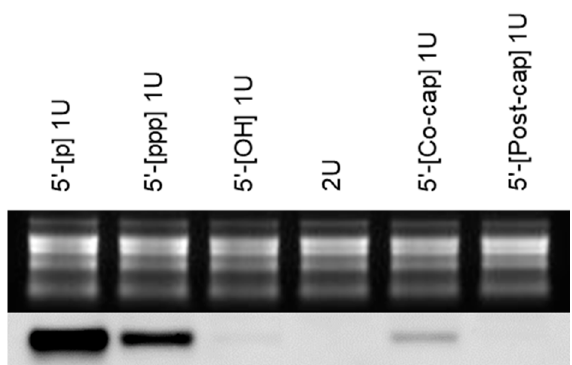
Figure 3. Northern blot hybridization using pooled total RNA extracted from tomato plants inoculated with the monomeric (1U) or dimeric (2U) RNA of potato spindle tuber viroid (PSTVd). Total RNA was individually extracted from five tomato plants, and equal quantities of total RNA were pooled and subjected to formaldehyde-denaturing agarose gel electrophoresis and visualized by Et-Br staining and UV irradiation (upper panel; loading control). Subsequently, RNA was transferred from the agarose gel to a nylon membrane and hybridized with a DIG-labeled cRNA probe specific for PSTVd (lower panel). Monomeric RNA possessed a different 5 (cid:48) -terminal structure; monophosphate (5 (cid:48) -[p] 1U), triphosphate (5 (cid:48) -[ppp] 1U), hydroxyl (5 (cid:48) -[OH] 1U), cap by co-transcriptional capping (5 (cid:48) -[co-cap] 1U), or cap by post-transcriptional capping (5 (cid:48) -[post-cap]